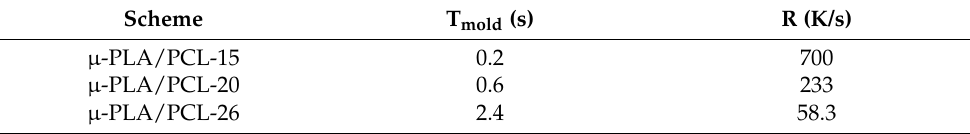
Table 2. The cooling parameters of microparts with different cavity size.